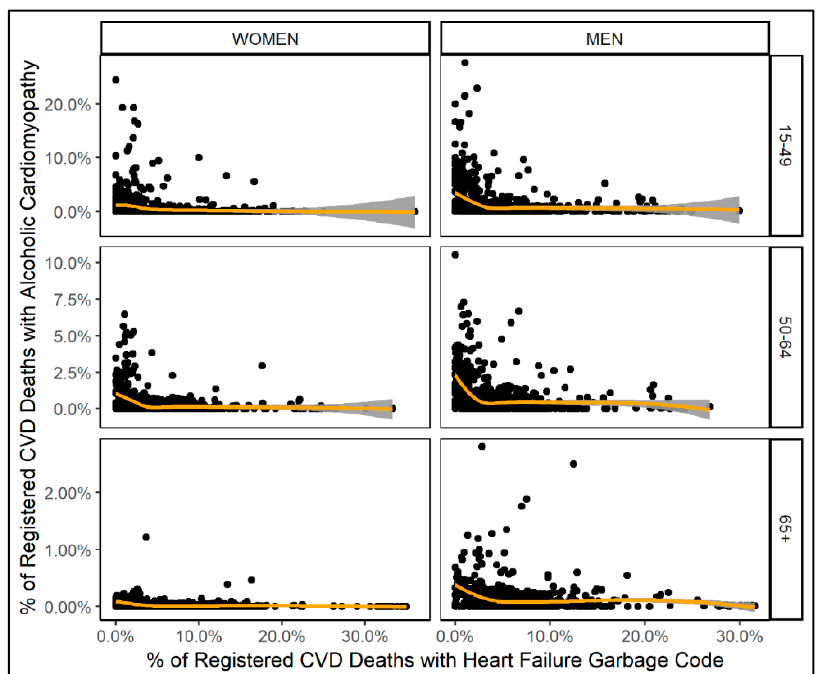
Figure 3. Scatter plots of proportion of heart failure garbage code deaths and proportion of ACM deaths among all CVD deaths by sex (column) and age group (row); orange line denotes the smoothing function of fitted proportion of ACM deaths among all CVD deaths obtained from multi-level models.